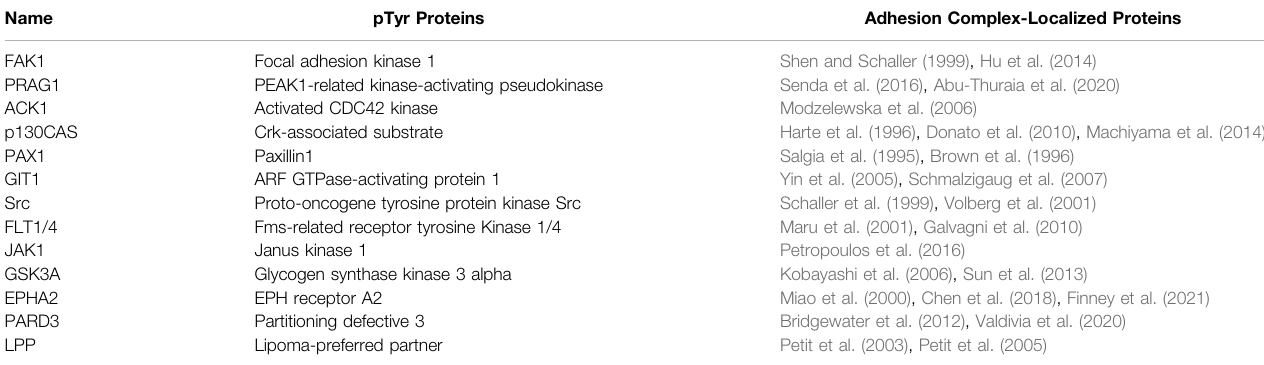
TABLE 1 | pTyr proteins enriched in Δ CK2 β MCF10A and localized in adhesion complexes. Name